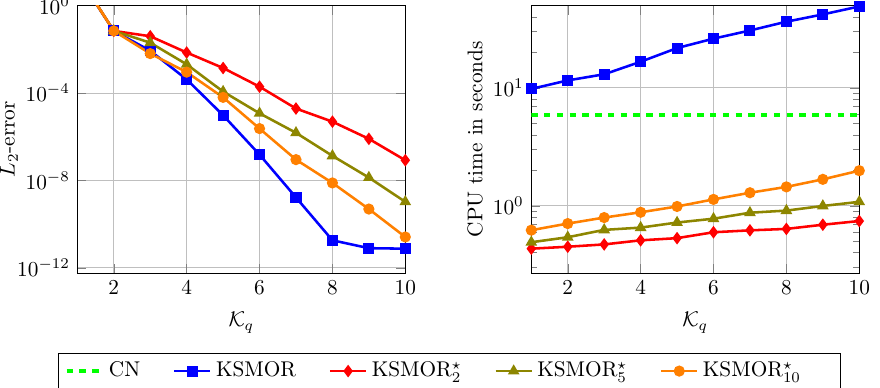
Figure A1. Results for the test example (A16)–(A19) at a fixed time t F = 5. Comparison of the L 2 -error ( left ) and the CPU time ( right ) between KSMOR and KSMOR (cid:63) for a different number of Krylov subspaces . The reference solution is computed with the direct CN method. In experiments, K q we study different numbers of snapshots s = 2,5,10 used for the KSMOR (cid:63) method, which is { } abbreviated as KSMOR (cid:63) s . Obviously, the KSMOR (cid:63) technique is much more efficient compared to the original KSMOR method as well as the CN